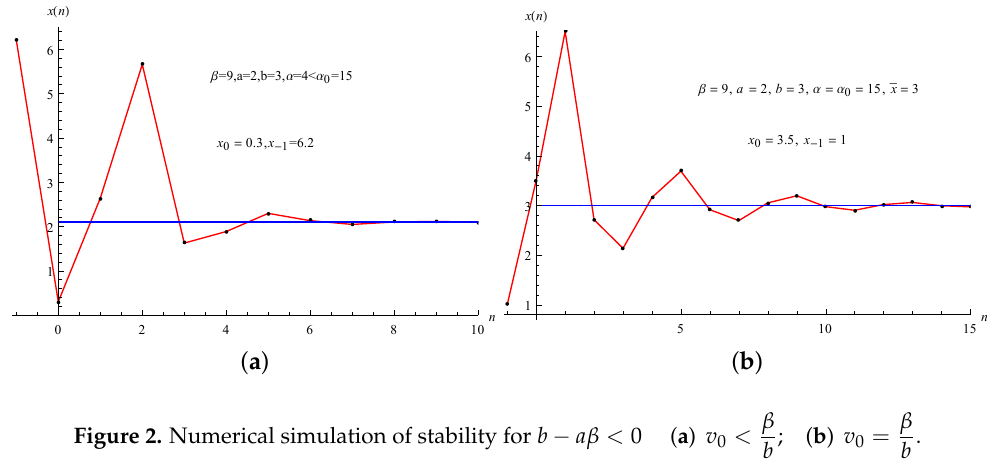
Figure 2. Numerical simulation of stability for b − a β <